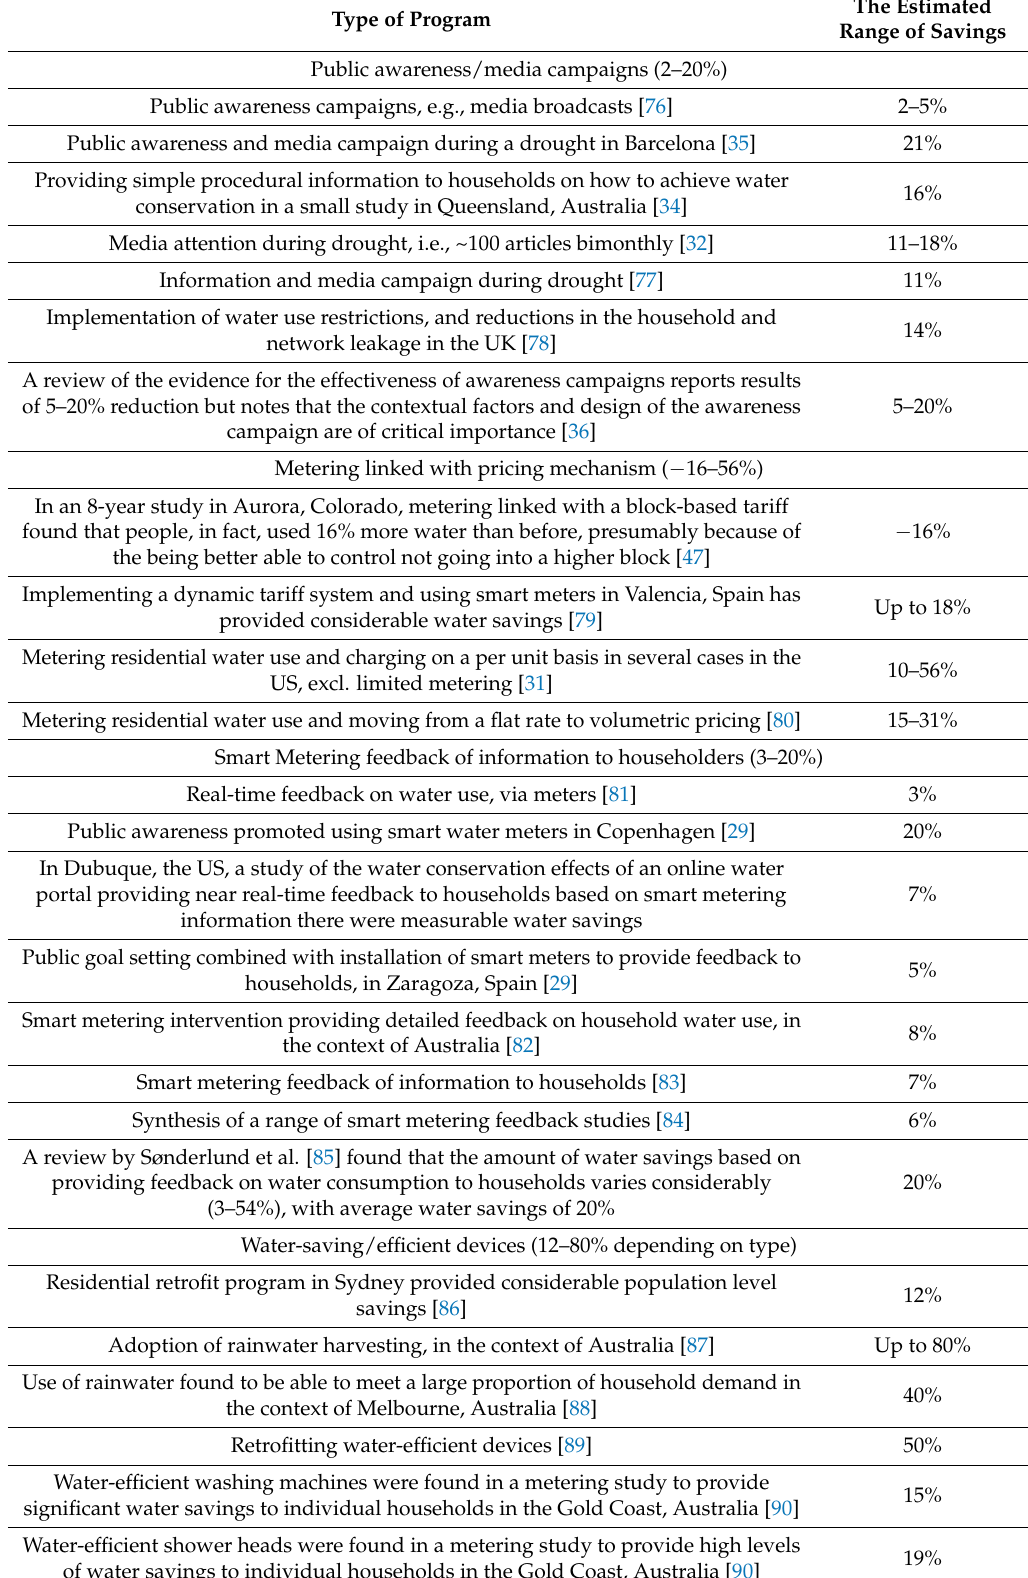
Table 2. Estimates of water savings from different types of water conservation programs. Ranges reported using the range of estimates in the different studies